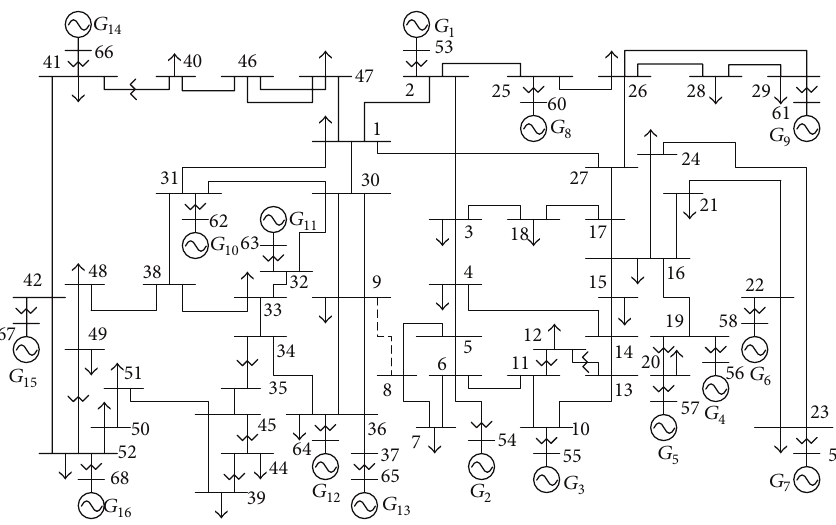
Figure 5: Simulation example of IEEE16-machine 68-bus benchmark